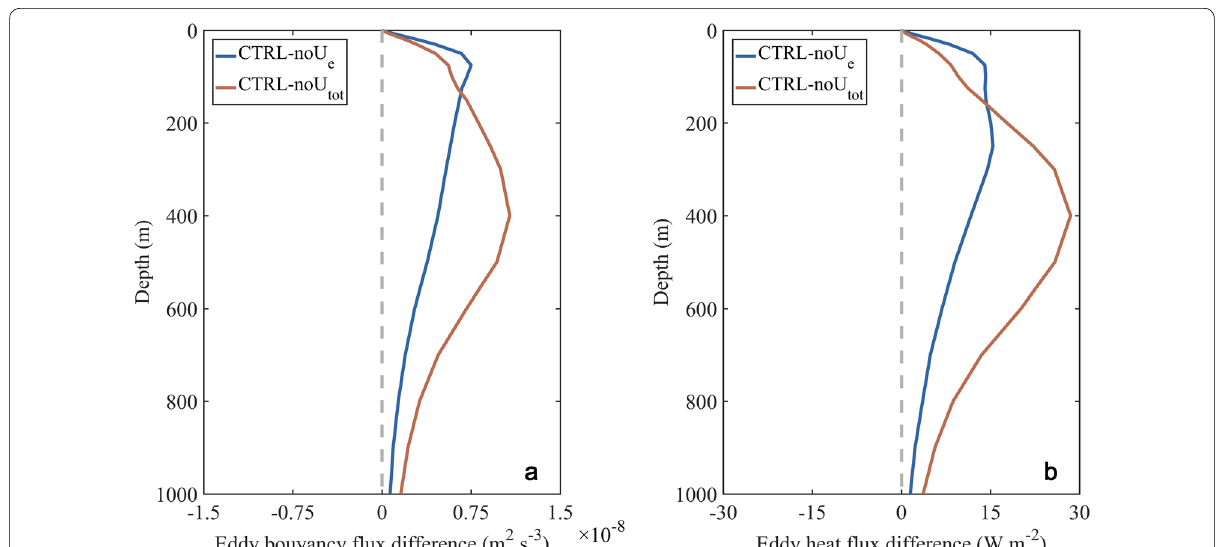
Fig. 4 The difference of 5-year wintertime mean vertical eddy fluxes averaged within the Kuroshio extension region. a Shows the difference of eddy buoyancy fluxes ( w ′ b ′ ) between CTRL and noU e (blue line) and that between CTRL and noU tot (red line). b Is similar to a but for eddy